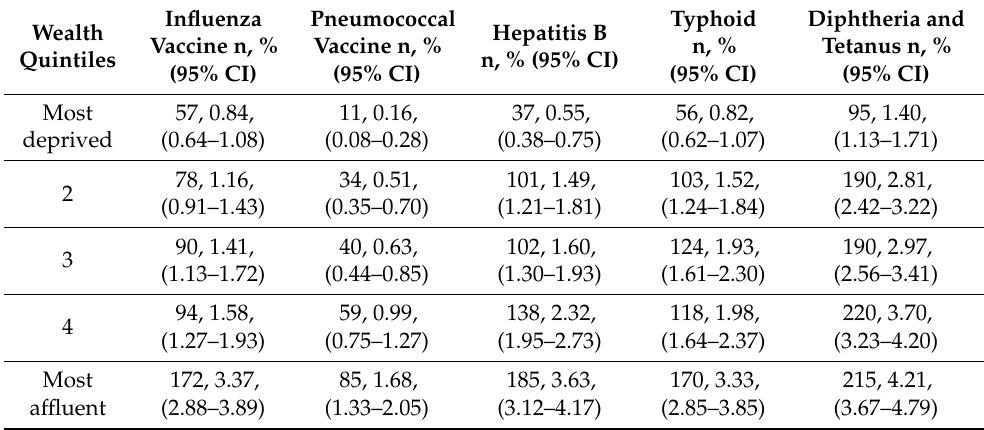
Table 2. Coverage of various adult vaccines across wealth quintiles among older adults in